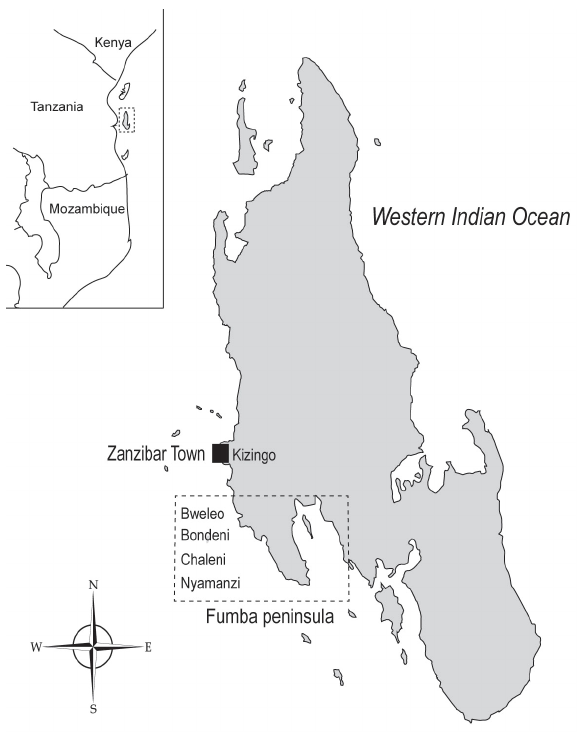
Fig. 1 . Study area of Zanzibar (Unguja), Tanzania: 06°08'00'' S, 39°19'00'' E. Sampled villages (n = 5) are found within the dotted square except Kizingo, which is located east of Zanzibar